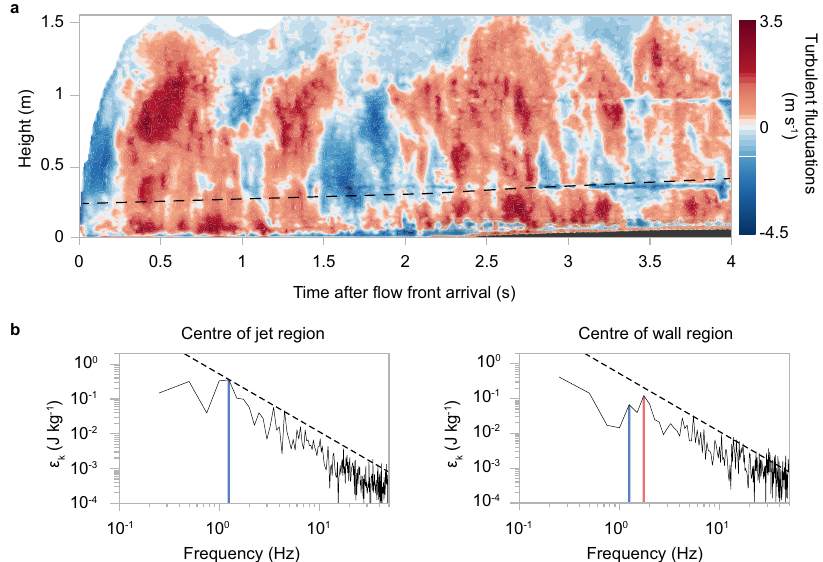
Fig. 6 Coherent turbulence structure as the origin for fl ow oscillations. a contour plot of turbulent fl uctuations u ’ (Eq. 3) against time at a static observer location of 3.12 m reveal long-period coherent turbulence structures of the experimental pyroclastic surge. The dashed line shows temporal variation of velocity maximum separating lower wall and upper jet regions. The aggrading deposit at the base of the fl ow is in dark grey. b spectra of speci fi c kinetic energy ε k (Eq. 5) measured in the centre of the jet (left) and wall regions (right). The frequencies of the two energy peaks at 1.25 Hz (blue line) and 1.75 Hz (red line) are highlighted. The dashed black lines show the − 5/3 Kolmogorov law of the inertial range of the turbulent energy cascade. The energy spectra are cut off at 50 Hz.